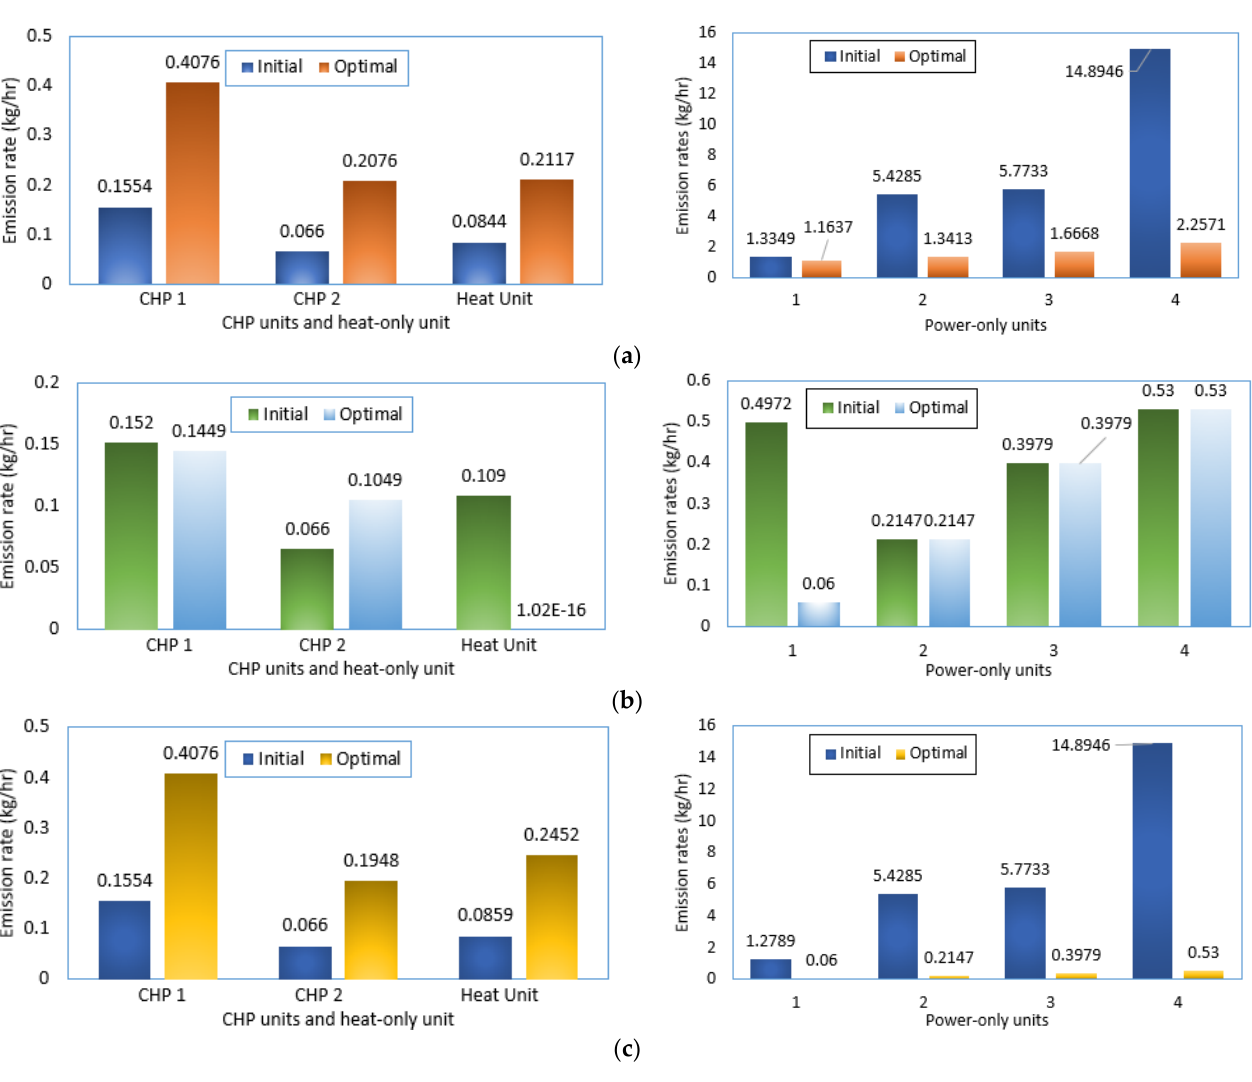
Figure 11. Emission rates of all the units of Case 4 for the three loading levels. ( a ) First Loading Level; ( b ) Second Loading Level; ( c ) Third Loading Level. ( b ) Second Loading Level; ( c ) Third Loading